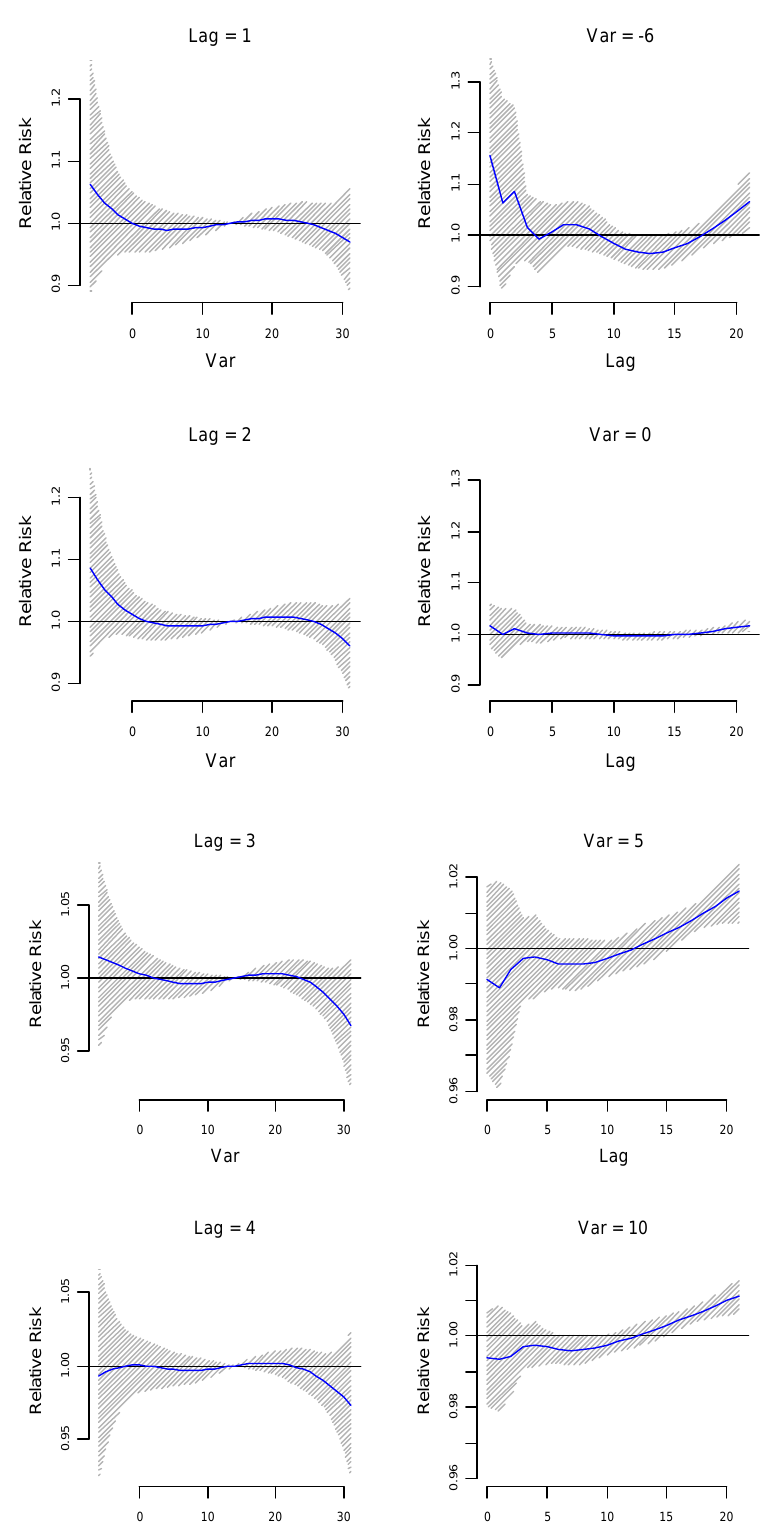
Figure 4. Lag-specific relative risk (RR) (at lower lags 1, 2, 3 and 4) estimates with their 95% confidence interval of preterm birth in different minimum temperatures (at –6 °C, 0 °C, 5 °C and 10 °C) using as a reference the median value of the whole annual series at 14 °C.